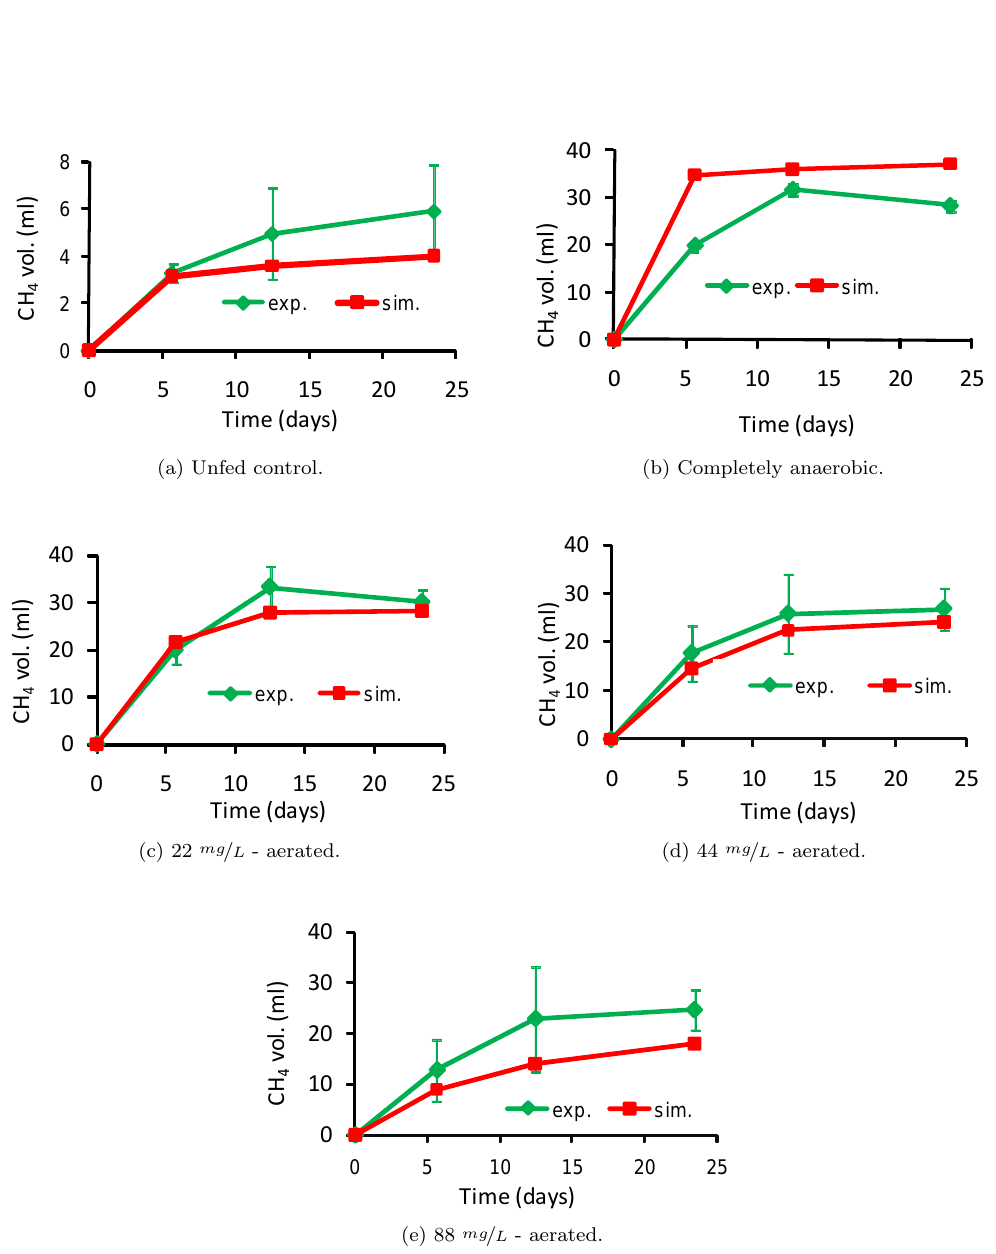
Figure 3: Cumulative methane generation measured in the control and in different air headspace experiments compared against simulation